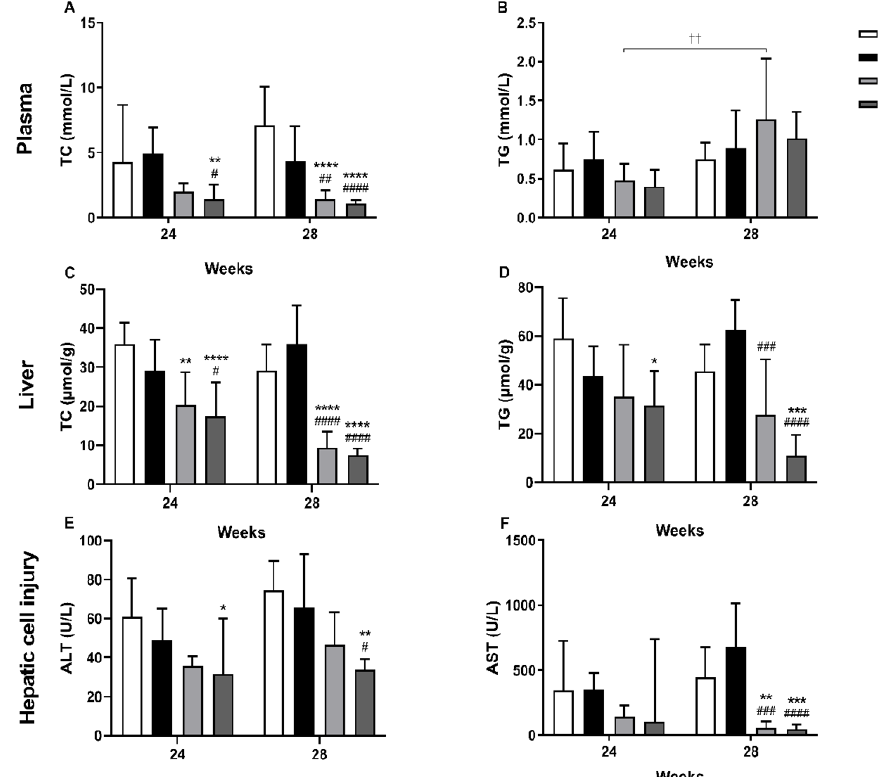
Figure 2. Evaluation of plasma and hepatic TC and TG levels and status of hepatic cell injury. ( A ) LF + were significantly decreased compared with HF and HF + after 24 weeks. After 28 weeks, both LF and LF + were significantly reduced compared with HF and HF + . ( B ) The level of TG in the LF group significantly increased over time. No further differences were detected between groups, although data indicate an increase in TG level in both LF and LF + over time. ( C ) Within 24 weeks, LF and LF + showed significantly reduced TC levels compared with HF. Furthermore, LF + were also significantly reduced compared with HF + . After 28 weeks, LF and LF + were significantly reduced compared with HF and HF + . ( D ) The LF + group showed decreased TG levels compared with HF after 24 weeks and decreased TG levels compared with HF and HF + after 28 weeks. The LF group were significantly reduced compared to HF + after 28 weeks. ( E ) Reduced levels of ALT were detected in the LF + group compared with HF after 24 weeks and compared with HF and HF+ after 28 weeks. ( F ) Both LF and LF+ displayed reduced AST levels compared with HF and HF+ after 28 weeks. Plasma TC and TG; Liver TC and TG, data are presented as mean ± standard deviation. ALT; AST, data are presented as geometric mean with 95% confidence intervals. * p < 0.05, ** p < 0.01, *** p < 0.001, **** p < 0.0001, compared with HF # p < 0.05, ## p < 0.01, ### p < 0.001, #### p < 0.0001, compared with HF + †† p < 0.01, LF Week 28 compared with LF Week 24. TC, total cholesterol; TG, triglyceride; ALT, alanine aminotransferase; AST, aspartate